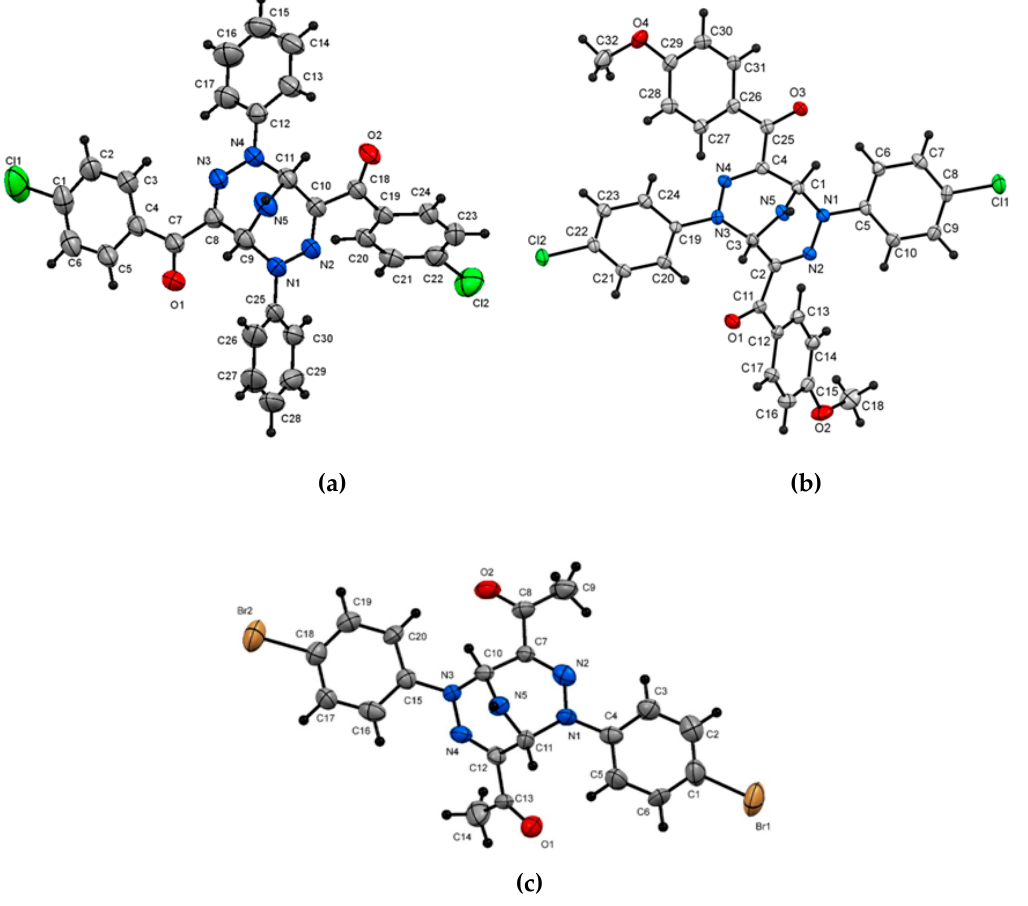
Figure 2. ORTEP diagrams of the crystal structures of 2f ( a ) , 2k ( b ) , 2p ( c ) .